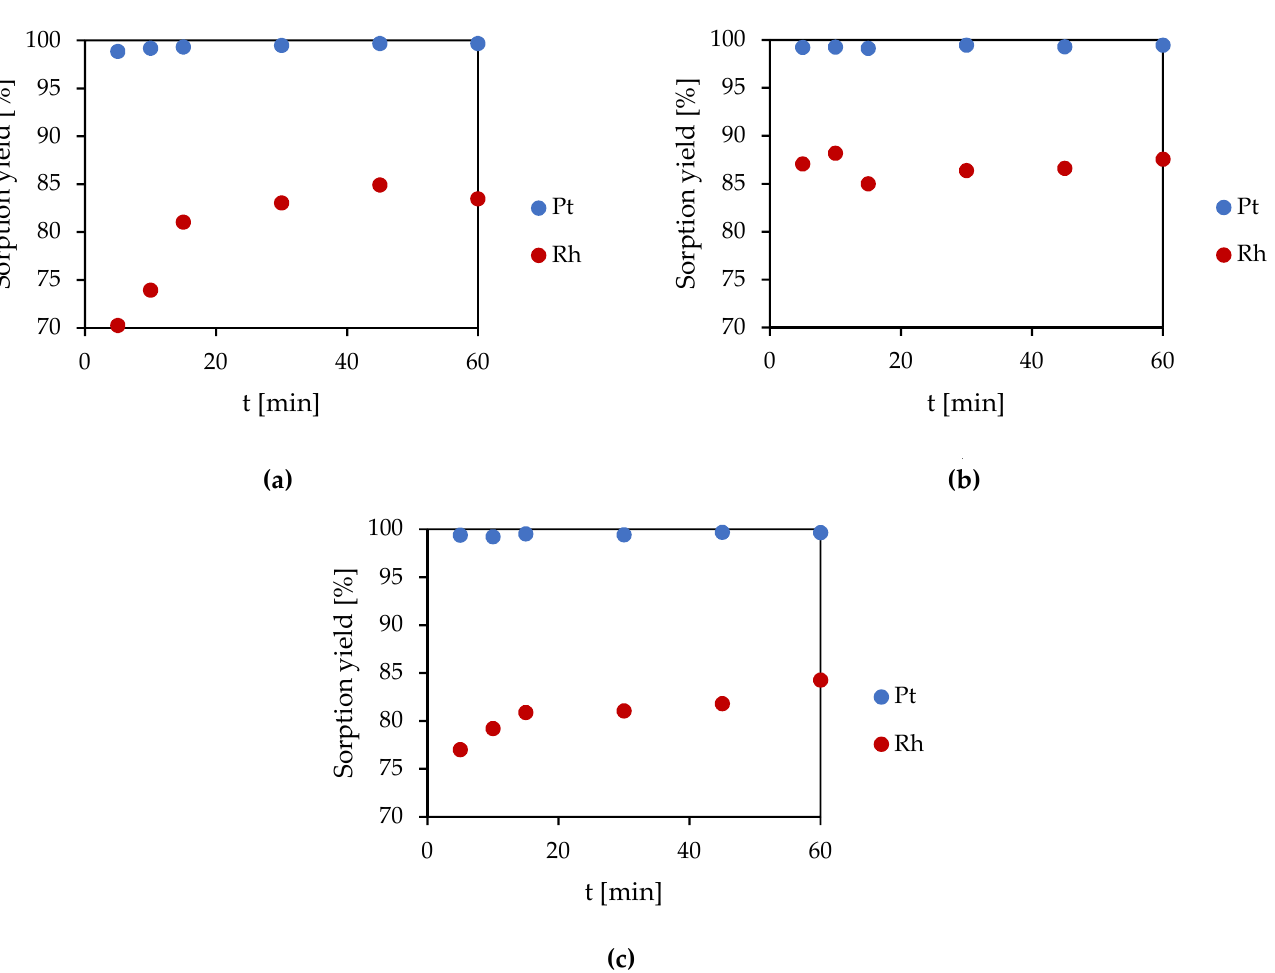
Figure 4. The dependence of the sorption yields on the process time for platinum and rhodium (V r :V s = 1:2, RT) for ( a ) Puromet MTS9200, ( b ) Puromet MTS9850, and ( c ) Lewatit K 6362.